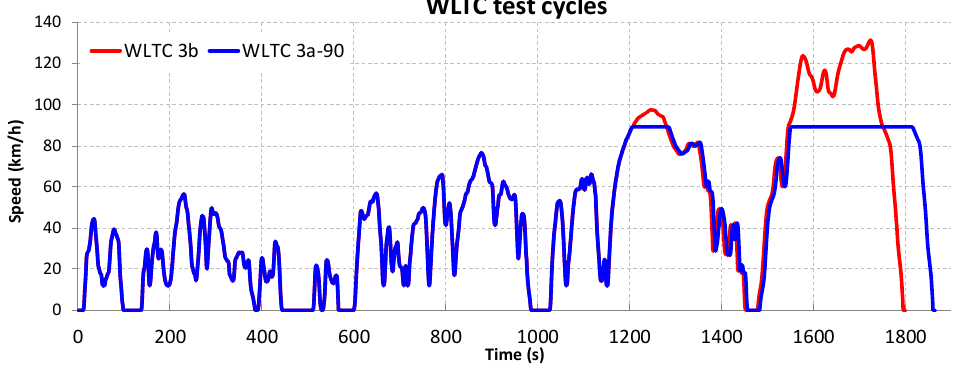
Figure 11. WLTC driving cycles.